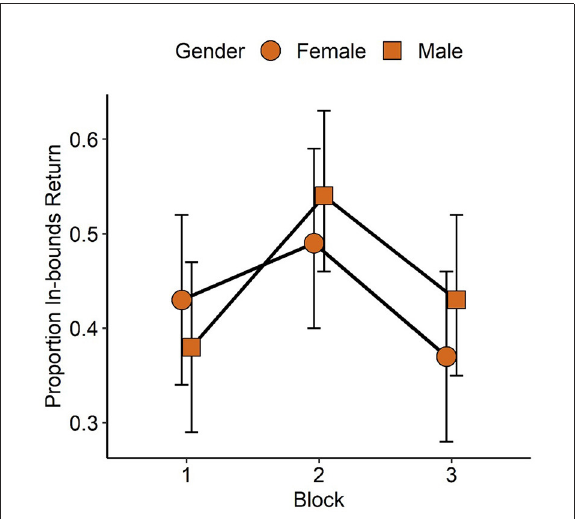
FIGURE3 Proportion of serve returns that were placed in-bounds as a function of participant gender groups and sequenced tennis task blocks. A significant gender by block interaction ( p < 0.05) was based on males exhibiting significant increase in proportion of in-bounds returns between block 1 and 2 but then no significant change to block 3, which was a transfer block involving novel serves and a novel serve sequence. Females did not exhibit significant changes between blocks 1 and 2 but then a significant decline in proportion of in-bounds returns at block 3. Error bars represent 95% confidence intervals.